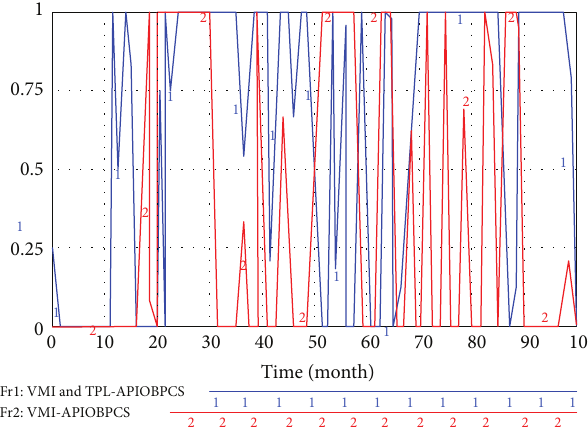
Figure 24: Fluctuation diagram of lower inventory level. Figure 25: The service level of VMI operational model under random demand.